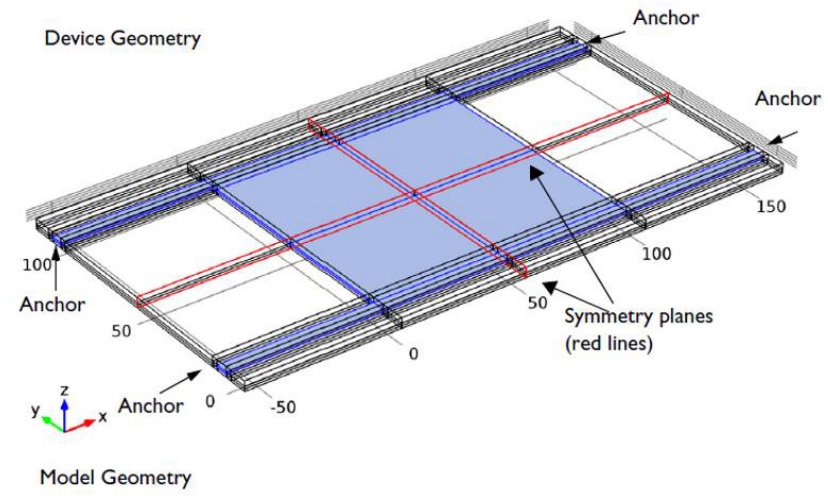
Figure 13. Schematic view of the RF MEMS device.